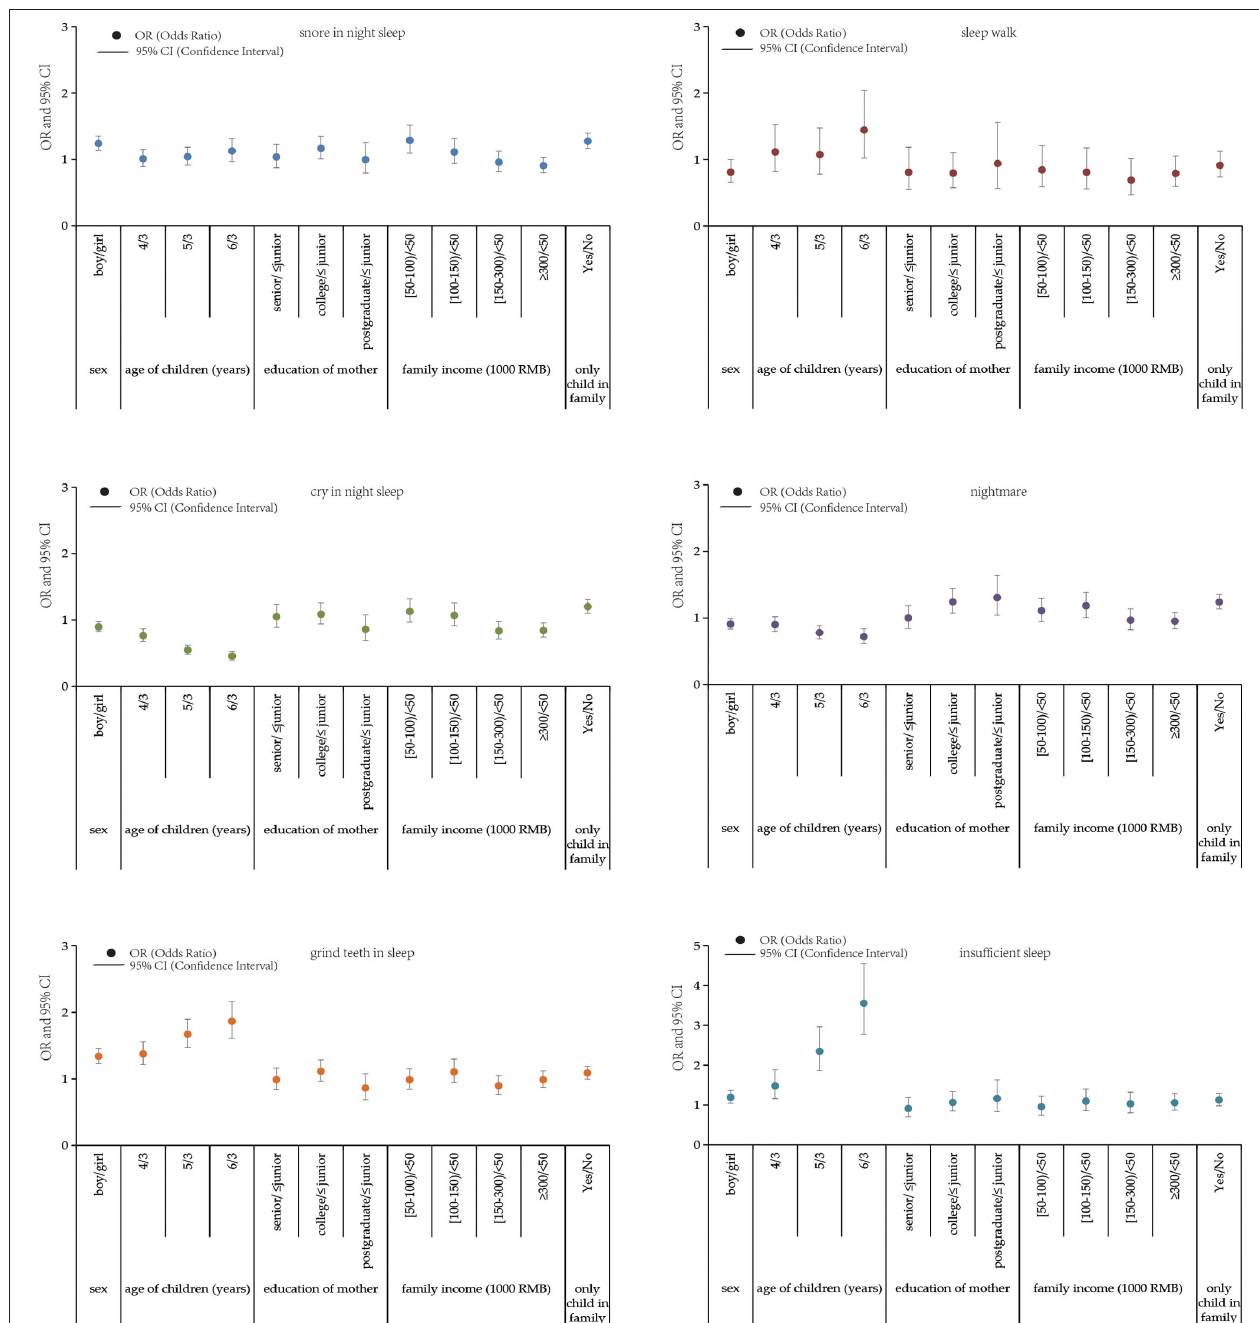
FIGURE 1 | The differences of each sleep problem prevalence among children with different demographic features, including sex, age of children, education of mother, family income, and the only child in the family.